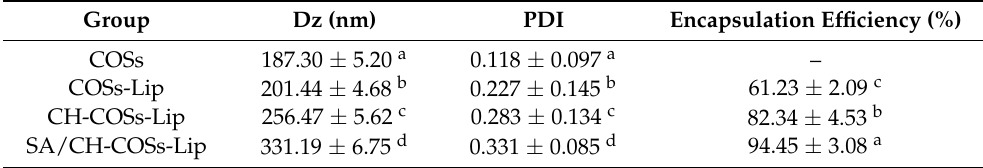
Table 1. Encapsulation efficiency, D Z , and PDI of COSs and different